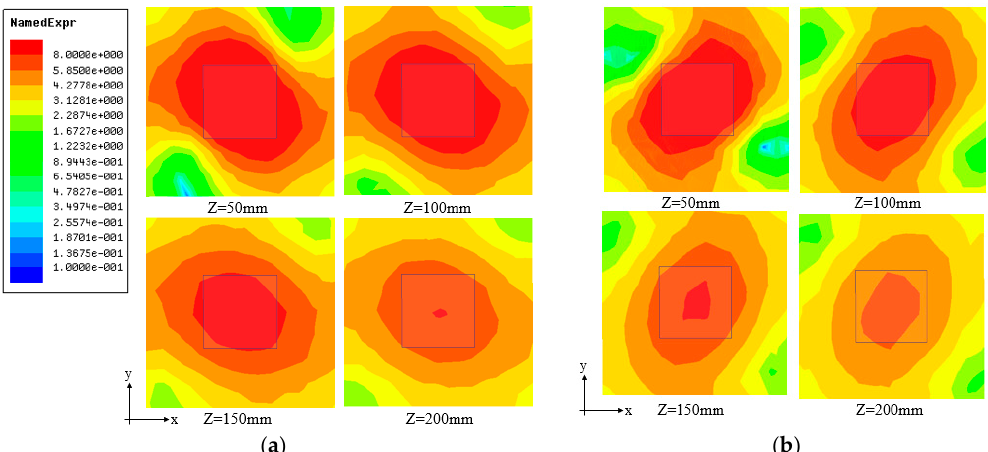
Figure 21. Simulated distribution of electric field components (Ex, Ey) of the antenna unit at different heights: ( a ) Ex distribution and ( b ) Ey distribution.